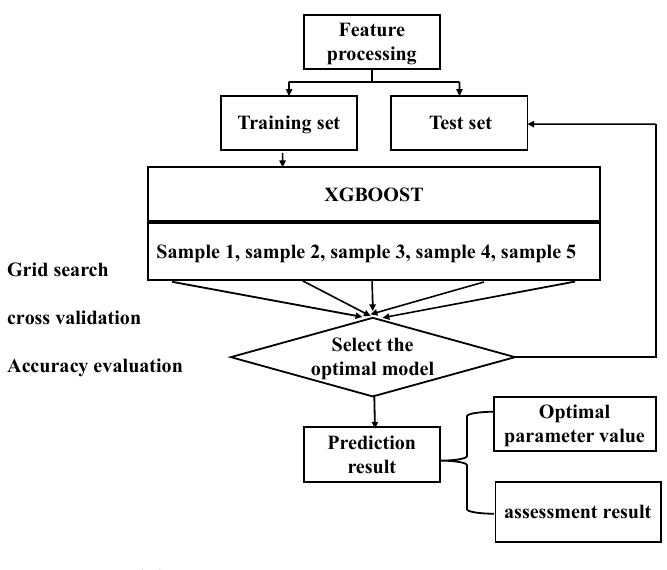
Figure 6. Model construction process.